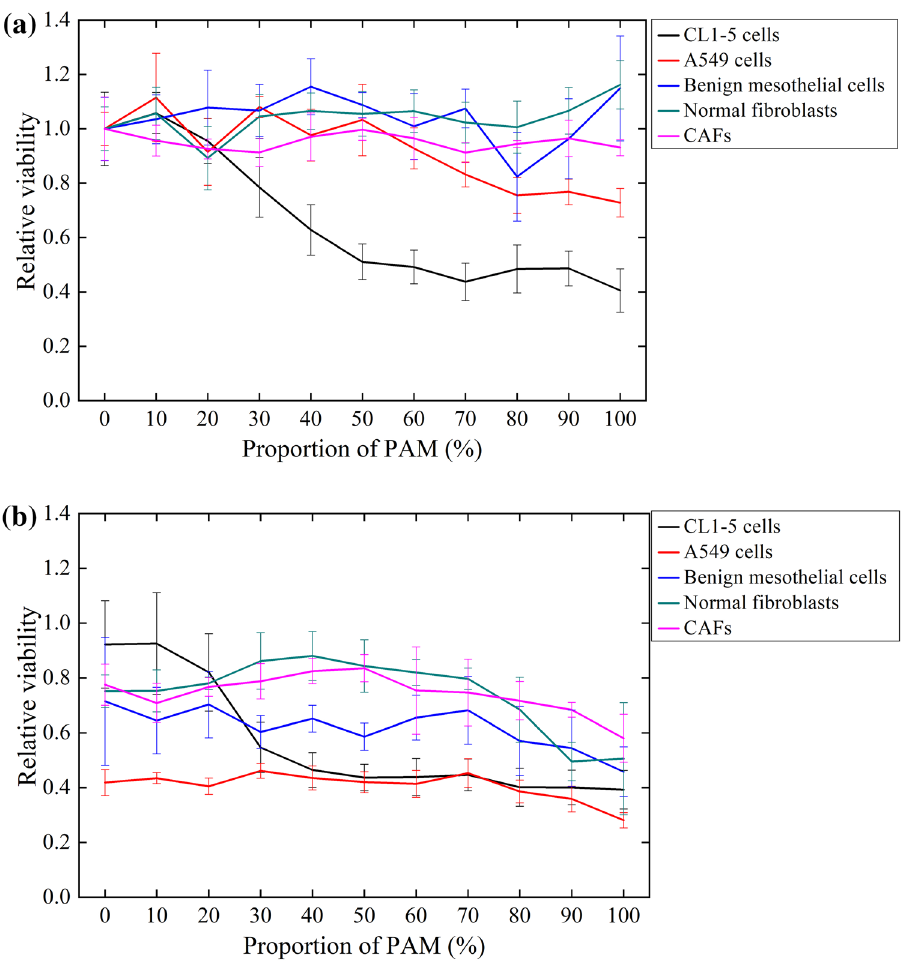
Figure 8. Various cell types were treated with PAM at 37 °C ( a ) and 43 °C ( b ) for 2 h. Relative viabilities are calculated comparing to the treatment of 0% PAM (RPMI without plasma treatment) at 37 °C. Cell viability was analyzed using an MTT assay at 1 day after the treatment. Data are mean and SD values (n = 3).